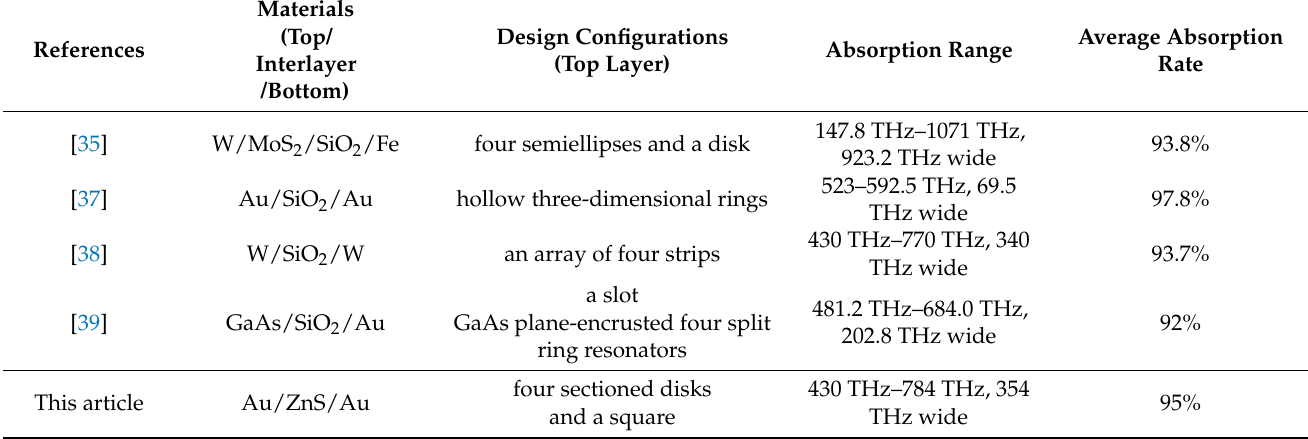
Table 2. Perfect absorbers for visible wavelengths in recent